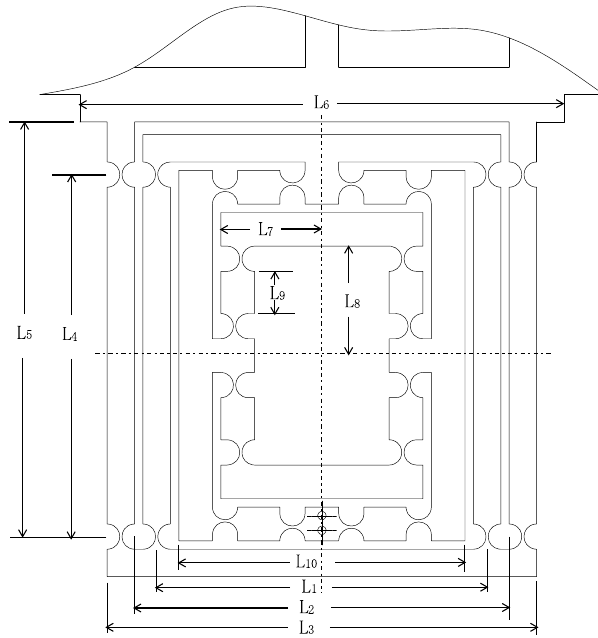
Figure 9. The main structural parameters of an XY decoupled compact parallel micromanipulator (DCPM). (cid:11)(cid:12)